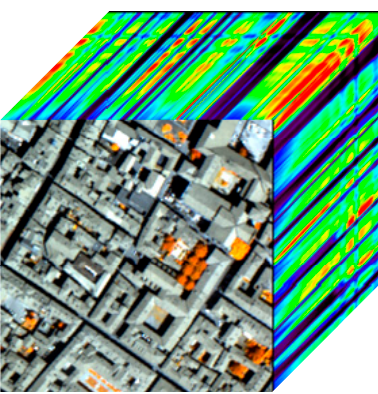
Figure 1. 3D-cube of Pavia Centre hyperspectral data set.